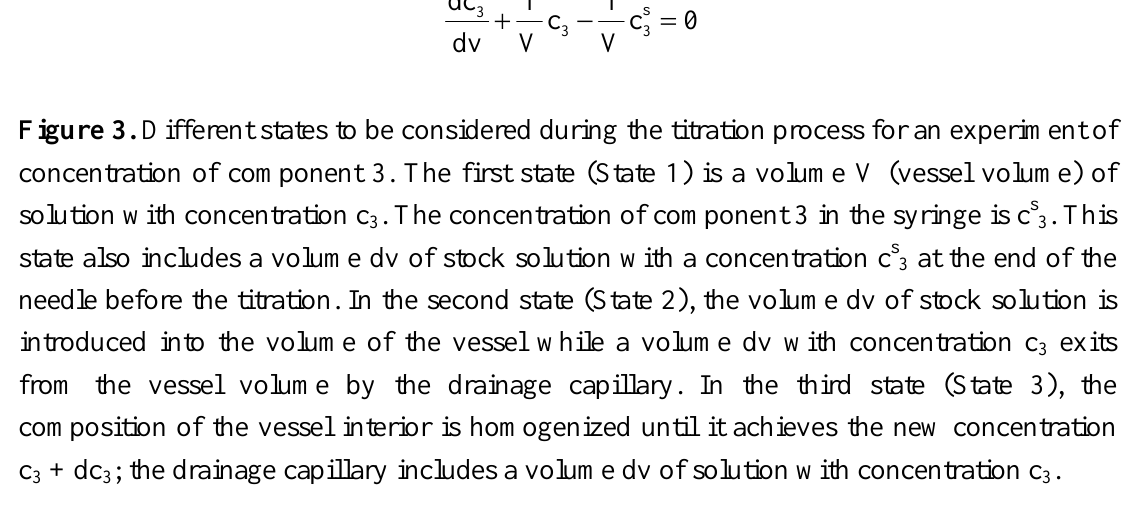
Figure 3. Different states to be considered during the titration process for an experiment of concentration of component 3. The first state (State 1) is a volume V (vessel volume) of solution with concentration c . The concentration of component 3 in the syringe is c s 3